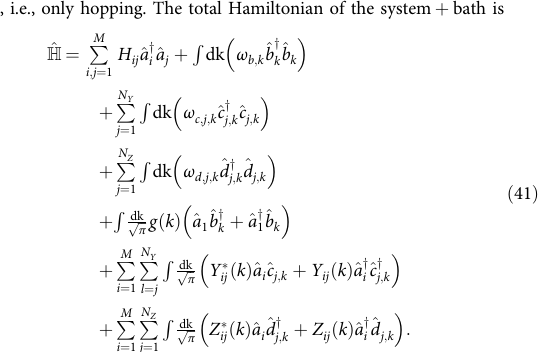
Fig. 6 Drive-detuning dependence of the output fi eld intensity. The dependence on of the output fi eld intensity P½ Δ (cid:3) (c.f., Eq. (39)) for a nonreciprocal system is described by Eq. (35). We have taken γ 1 = 0.5 κ , γ = κ , ν = 4 κ . a Spectrum for ϵ ¼ 0, when the system is fully 2 2 nonreciprocal. Even though the system has two nondegenerate eigenvalues Ω ± [0], only one resonance is seen, as nonreciprocity makes the to the incident drive. Note that this spectrum is independent of J . b Black dashed: Spectrum where the parameter to be sensed ϵ ¼ 0 : 3 κ , but without nonreciprocity ( J = 0). The spectrum only has a single dip, and almost identical to the ϵ ¼ 0 spectrum. Red and green: spectra with the same perturbation ϵ ¼ 0 : 3 κ , but with nonreciprocal couplings J = 20 κ and J = 50 κ , respectively. Two resonances are clearly observed, and their separation increases with the strength of the nonreciprocal coupling